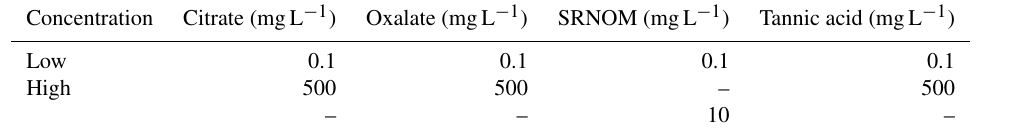
Table 2. Concentration variations of plant exudates (citrate and oxalate) and soil components (tannic acid and organics: Suwanee River natural organic matter, SRNOM) used to create the solutions tested in this work. The middle row shows high concentrations of the constituent, the bottom row shows a moderately high amount, and the top row shows a typical natural concentration.